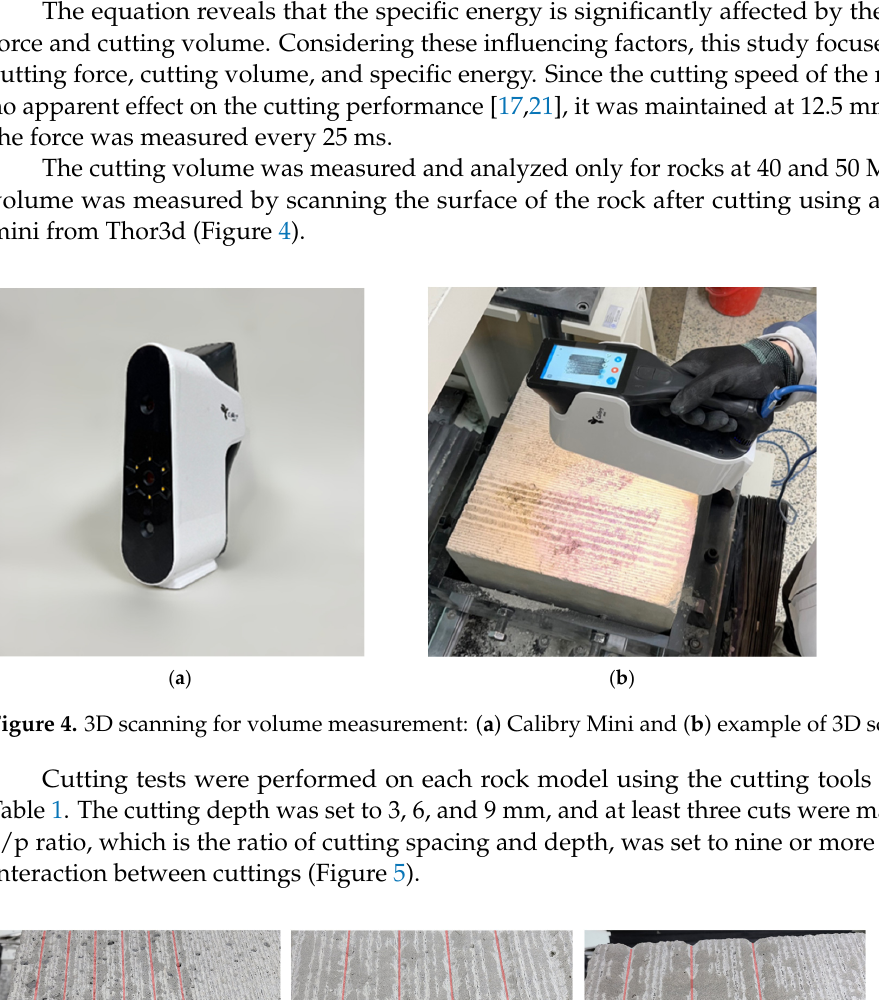
Figure 5. Cutting spacing by penetration depth: ( a ) depth: 3 mm, spacing: 30 mm, ( b ) depth: 6 mm, spacing: 55 mm, and ( c ) depth: 9 mm, spacing: 85 mm.